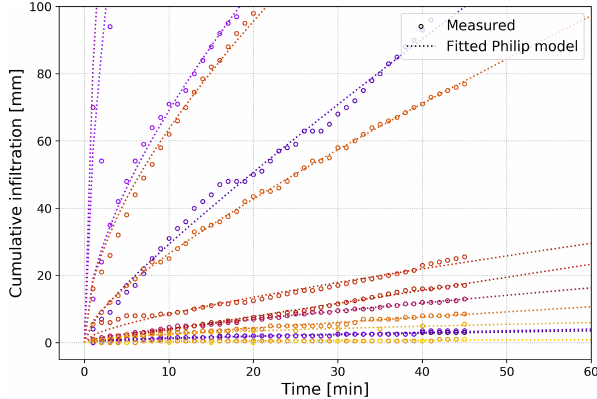
Figure 10. Temperature–depth profiles measured at cluster H on 6 August 2018 at the vegetated plot (a) and the paved plot (b) .